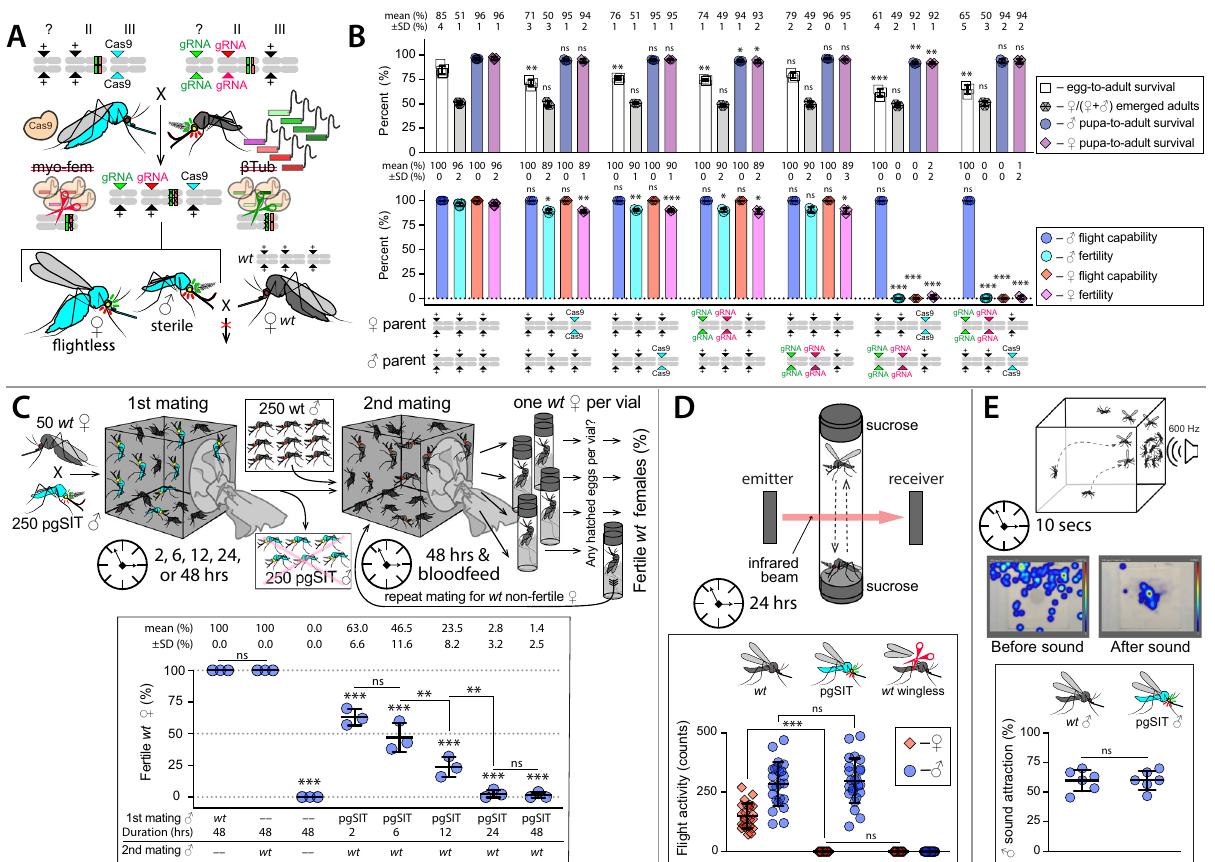
Fig. 2 Genetic characterization of pgSIT. A The pgSIT cross between double-homozygous gRNA ♂ ’ s harboring both gRNA β Tub #7 and gRNA myo-fem #1 (termed: gRNA β Tub + myo-fem ) and homozygous Cas9 ♀ ’ s. The pgSIT cross was initiated reciprocally to generate F 1 transheterozygous progeny carrying either maternal or paternal Cas9 (Supplementary Fig. 4). B Bar graphs comparing the percentage of transheterozygous and heterozygous Cas9 or gRNA progeny to those of WT (data can be found in Supplementary Table 4 and Supplementary Video 4) over at least three ( n ≥ 3) biologically independent F 1